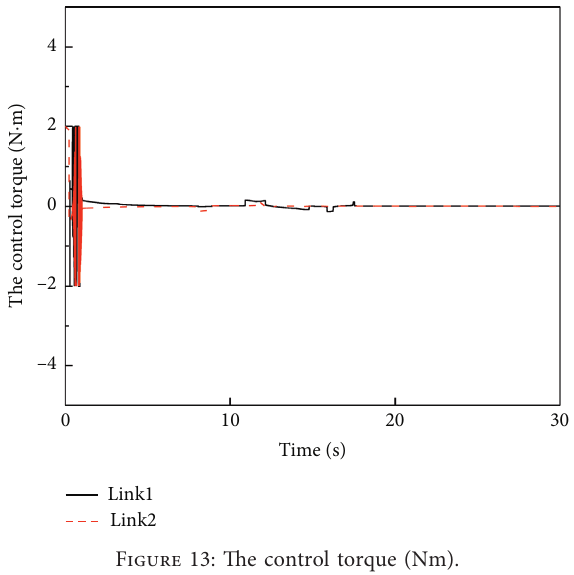
Figure 13: The control torque (Nm).